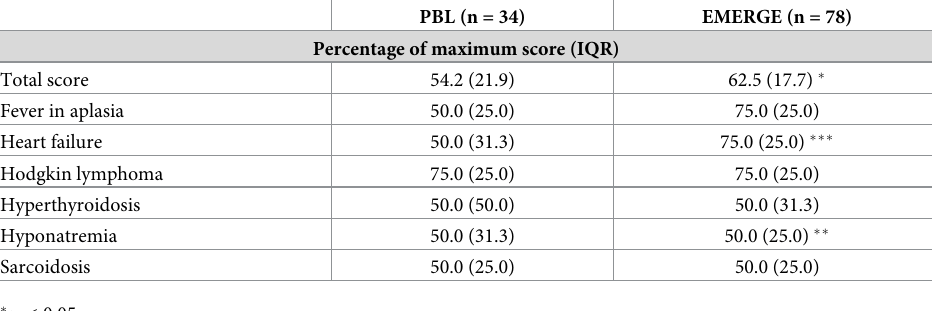
Table 2. Student performance in the final exam part key